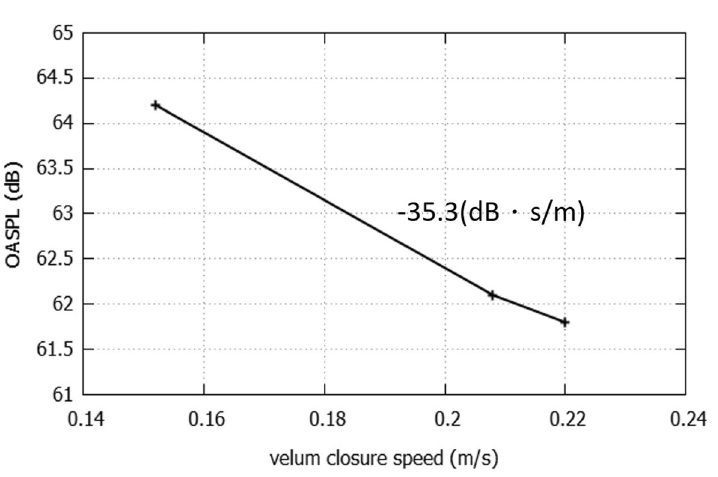
Figure 8. The relation between OASPLs during the phonation process and the velum closure